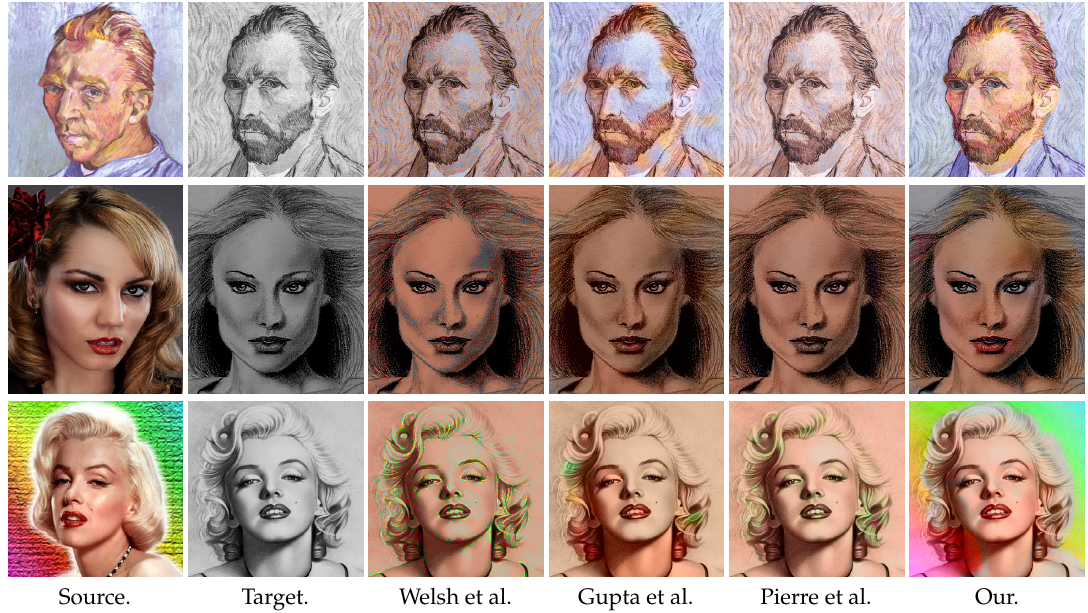
Figure 6. Results including painted faces. Only our morphing method is able to colorize the target images in an authentic